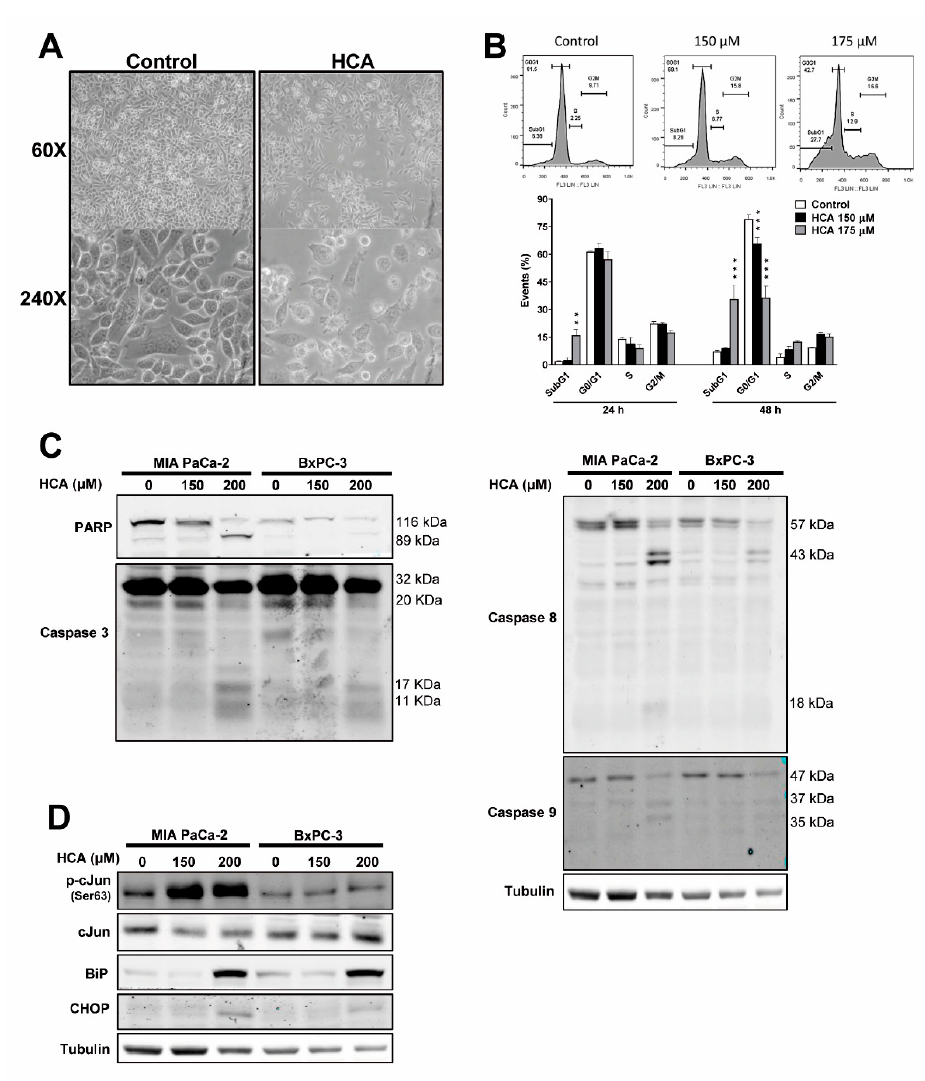
Figure 2. HCA induces intrinsic and extrinsic apoptosis, and ER Stress/UPR signaling, in pancreatic cancer cells. ( A ) Representative microscopy images (60× and 240× magnification) showing the effects of HCA (200 µM for 48 h) on MIA PaCa-2 cells. ( B ) Representative histogram of the cell cycle phases and quantification of the cell populations at different phases of the cell cycle: distribution of MIA PaCa-2 cells incubated with or without HCA (150 or 175 µM) for 24 and 48 h (mean ± SEM of three independent experiments). ( C ) Representative immunoblots of the effect of HCA (150 or 200 µM for 48 h) on the PARP, caspase 3, 8, and 9 proteins in MIA PaCa-2 and BxPC-3 cells, and the amount of tubulin as a loading control. ( D ) Representative immunoblots of the effect of HCA (150 or 200 µM for 48 h) on c-Jun phosphorylation, and on the BiP, CHOP proteins in MIA PaCa-2 and BxPC-3 cells, with tubulin as a loading control. Student’s t -test: ** p < 0.01, *** p < 0.001 relative to the controls. HCA, 2-hydroxycervonic acid; BiP (a.k.a. GRP78), glucose-regulated protein 78; c-Jun, Jun Proto-Oncogene; CHOP (a.k.a. DDIT3), DNA Damage Inducible Transcript 3; PARP, Poly (ADP-Ribose) Polymerase.